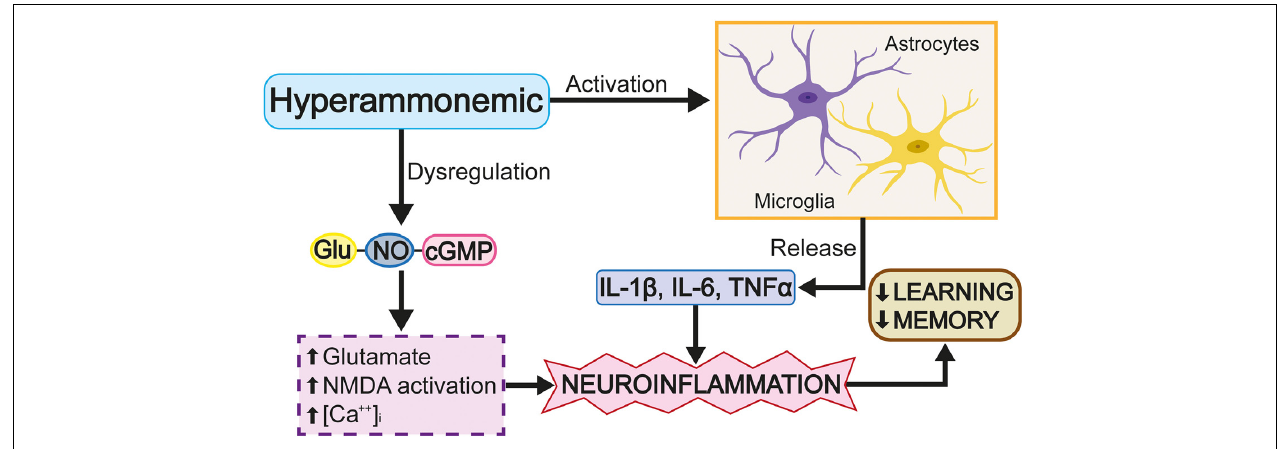
FIGURE 7 | The excess of glutamate activates cGMP. Glutamate activates iNOS, produces nitric oxide (NO) and leads to the activation and extracellular release of